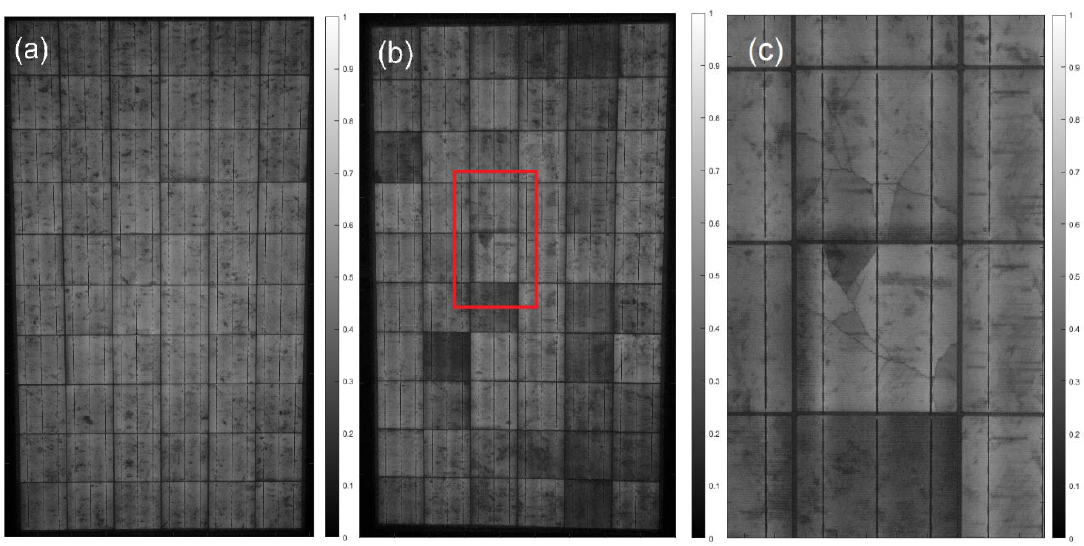
Figure 5. Electroluminescence images. ( a ) Module without defected cells, selected for the study; ( b ) non-selected module showing defects in some of its cells; ( c ) enlarged image from the red square in ( b ) to show the fractured cells of the non-select module.